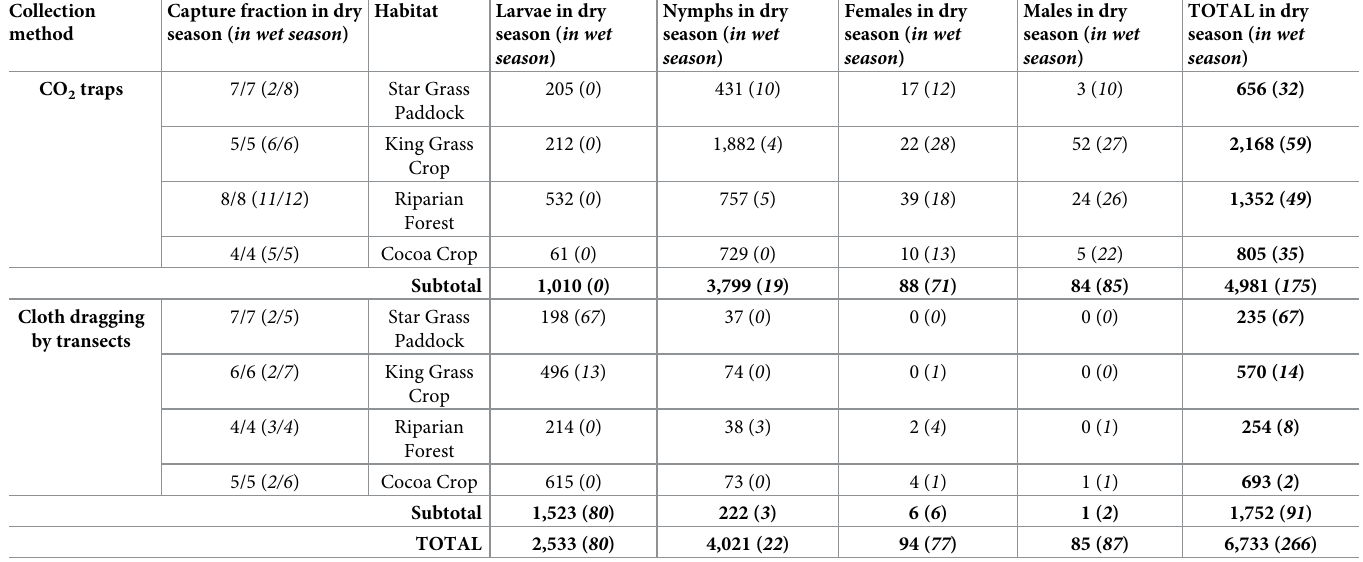
Table 2. Number of collected and identified A . mixtum specimens according to collection method, season, habitat type, and stage. Collection Capture fraction in dry Habitat method season ( in wet season ) CO 2 traps